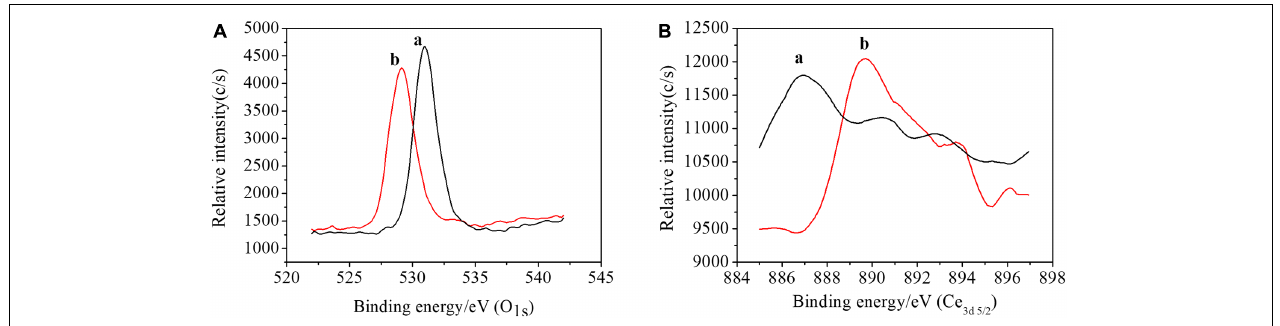
FIGURE 7 | The XPS spectra of AtFLA11 with [(a), black line] or without [(b), red line] Ce(III). (A) O 1s ; (B) Ce 3 d 5 / 2 . The measurements were carried out 12 h after incubating AtFLA11 with Ce(III).